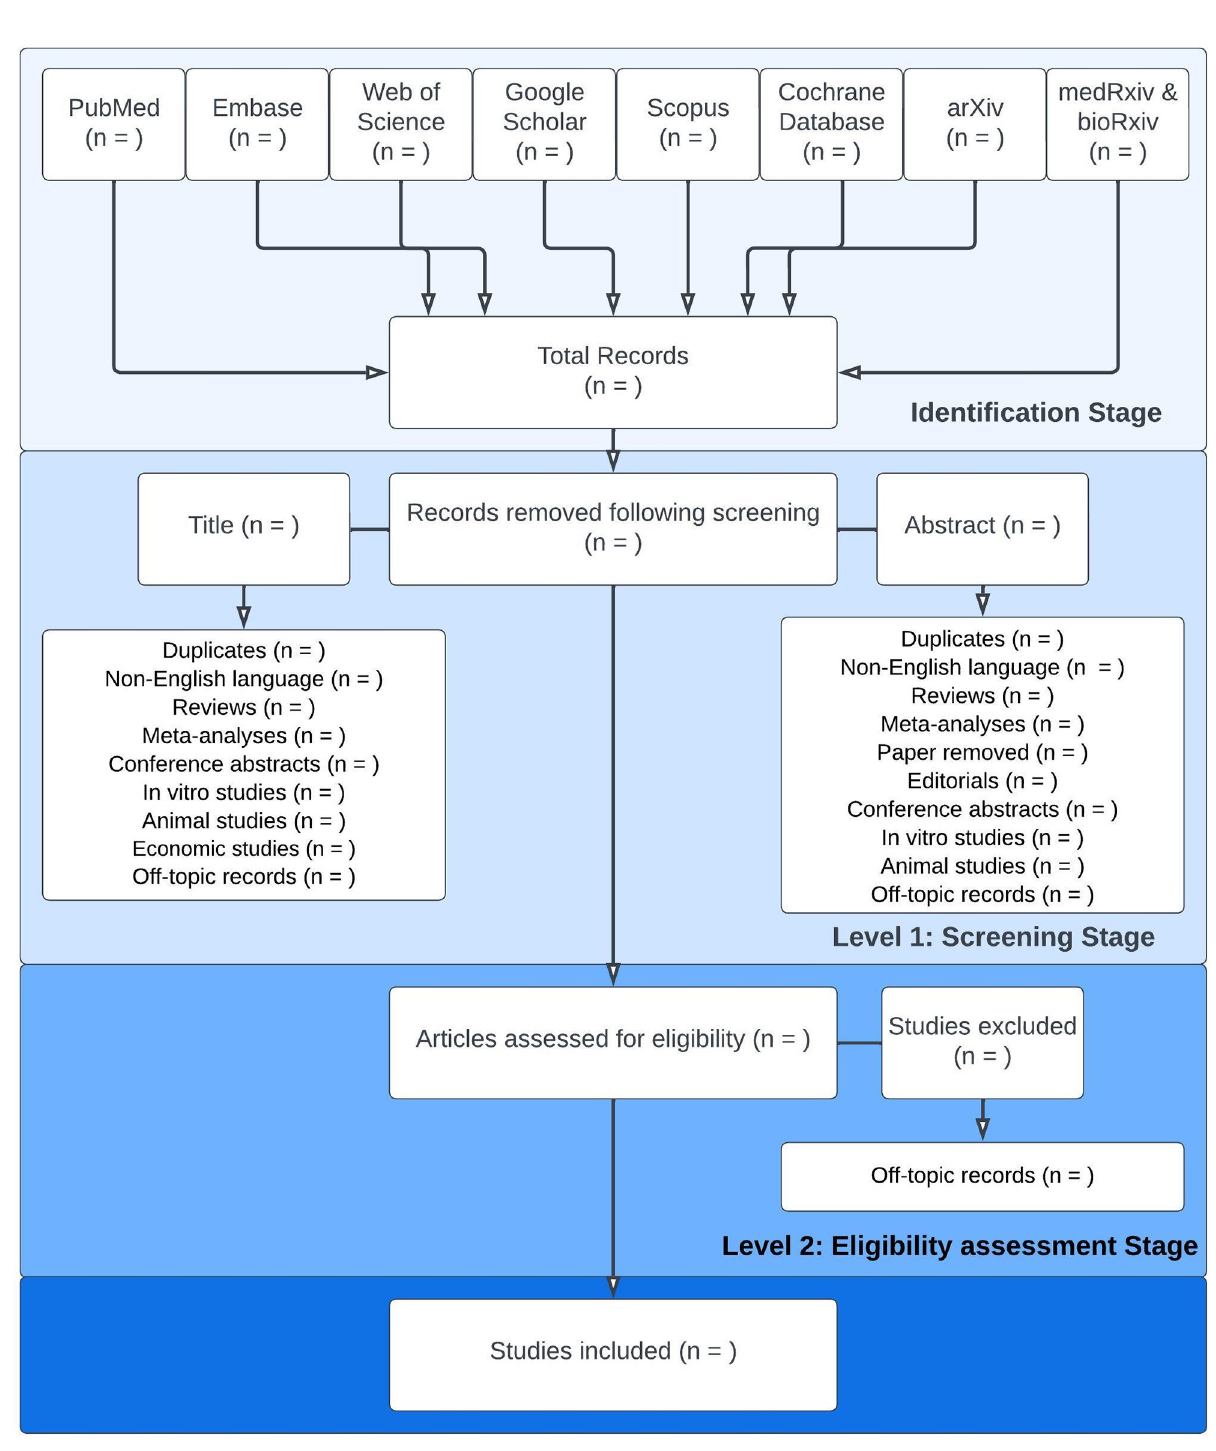
Fig 1. PRISMA flow diagram. An illustration of the process of selecting studies for review.